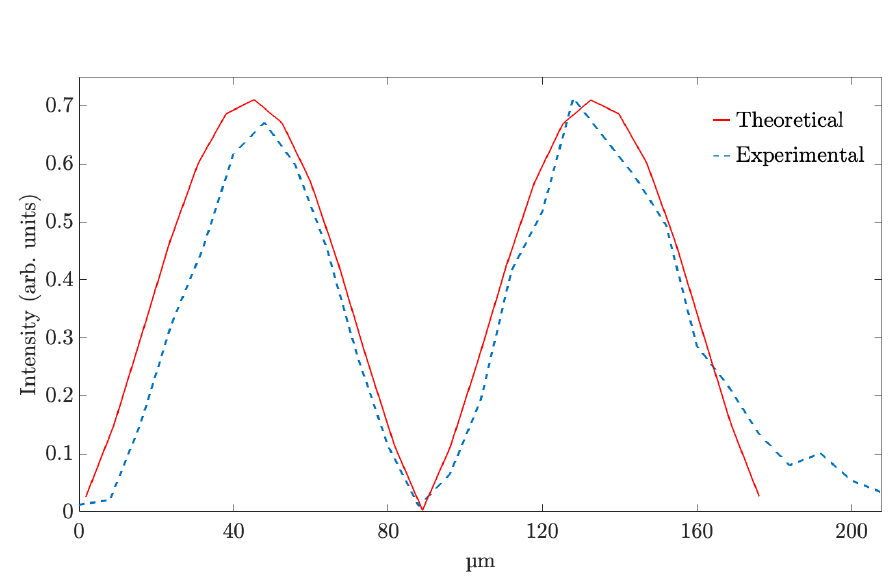
Figure 4. Intensity profile of theoretical and experimental fork gratings.